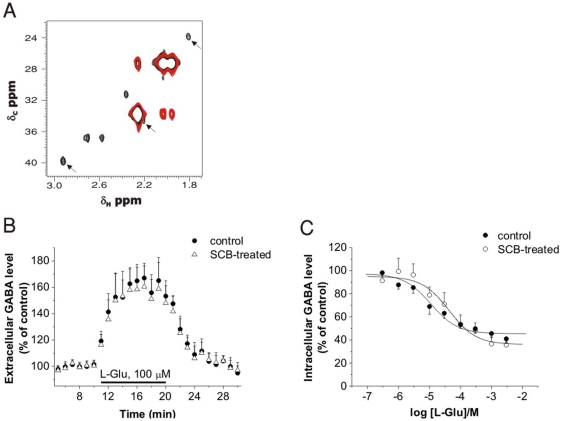
Glu-evoked GABA release is independent of glutamate decarboxylase.(A) Contour plot representations of gradient enhanced 1H/13C heteronuclear single quantum coherence (13C-HSQC) spectra of extracellular fluid sample from rat cerebrocortical NPMV after incubation with [U-13C/15N]Glu for 30 min in control (black) and semicarbazide (SCB)-treated animal (red). GABA resonances (arrows) do not appear in the samples from SCB-treated animal. (B) Elevation of [GABA]o in acute rat hippocampal slices in control (n = 6) and SCB-treated animals (n = 7; P = 0.54; 145±14% of pre-stimulus control). (C) Intracellular [3H]GABA level as determined by [3H]GABA uptake in the presence of 100 µM NNC-711 in control condition and in SCB-treated animals (n = 3, P = 0.85).